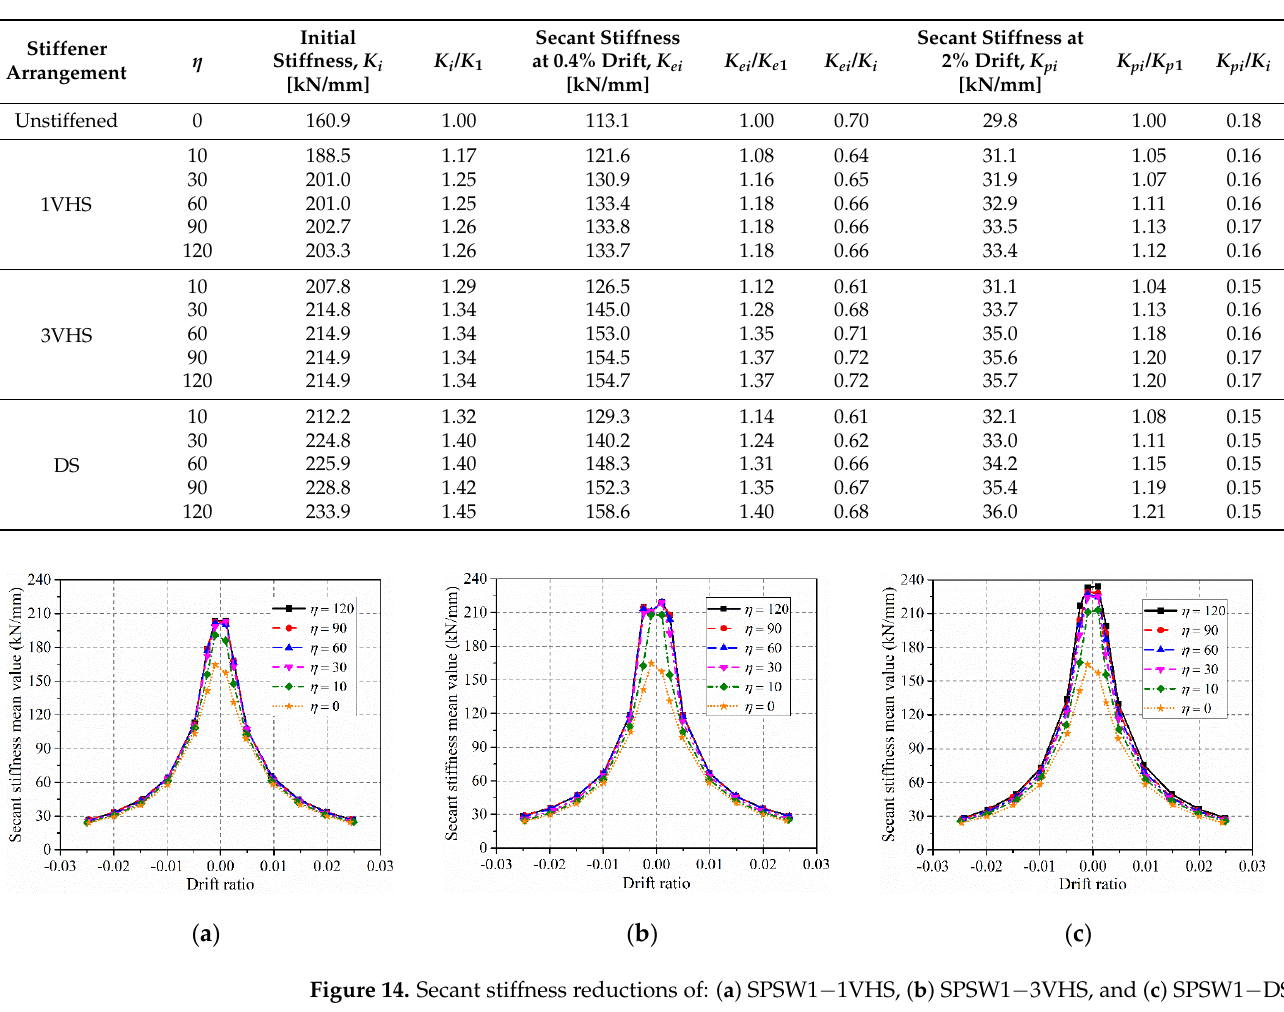
Table 4. Stiffness results of the SSPSWs with variable η .